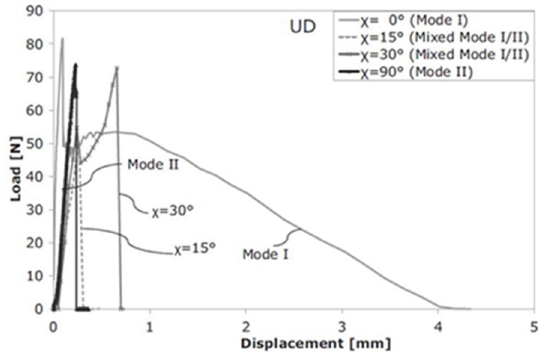
Figure 23. E ff ect of mode mixicity angle on single z-Pin response (CFRP z-Pin, d = 0.28mm, [0] pre-preg) [31].